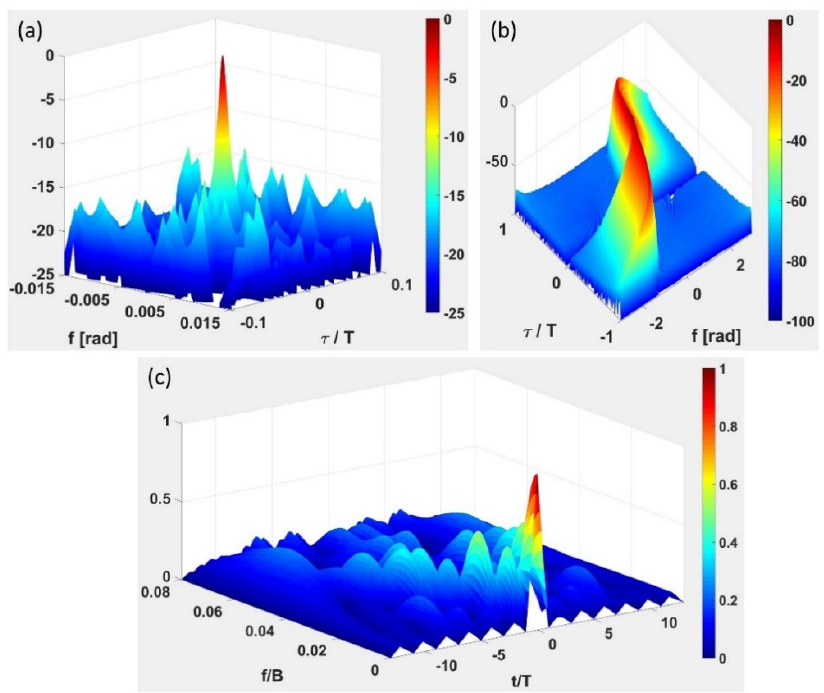
Figure 1. Ambiguity function (values in dB for ( a , b ) and in linear scale for ( c )): ( a ) Noise waveform (BT = 100); ( b ) non-linear frequency modulated (NLFM) “chirp” signal (BT = 100), and ( c ) 13-elements Barker code. The low and impractical BT values are here chosen for the clarity of display.